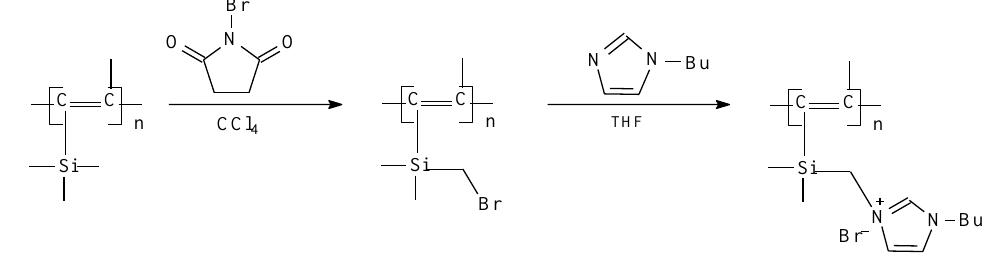
Figure 1. Modification of PTMSP by the butylimidazole salt.